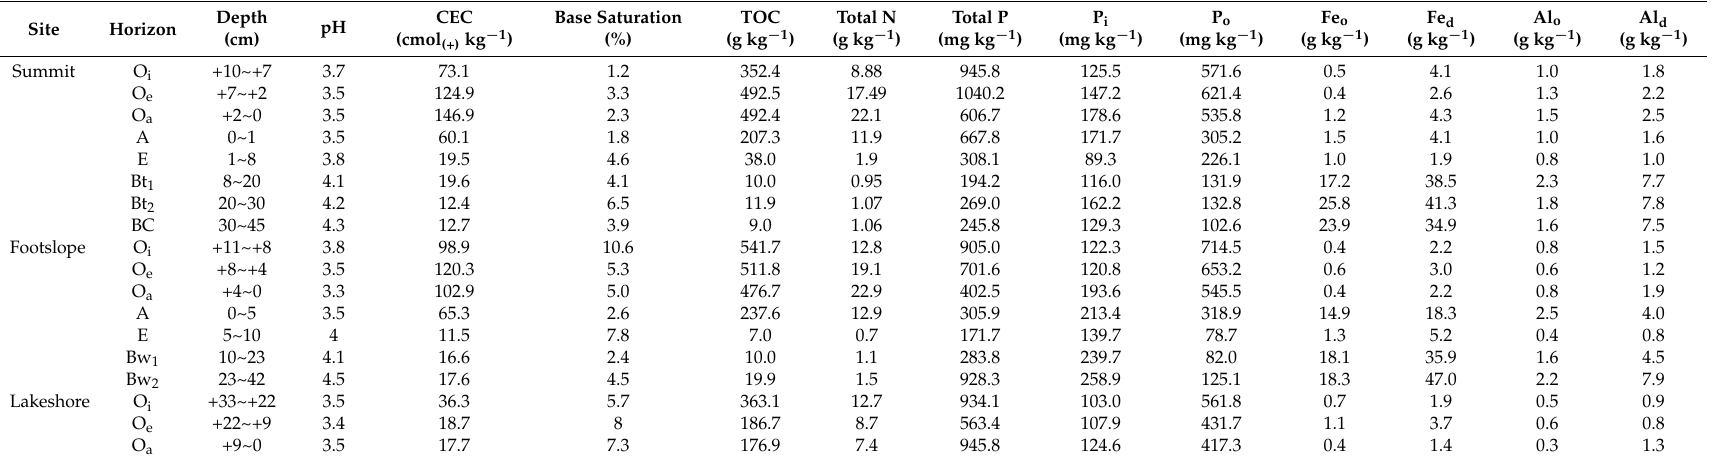
Table 1. General chemical properties of studied soils.